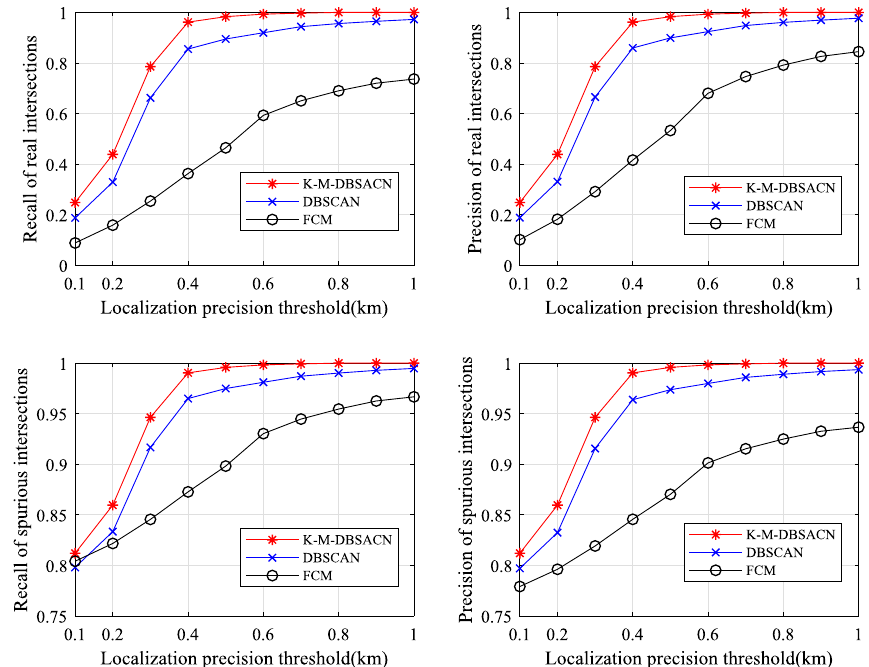
Fig. 9 Comparison of recall and precision versus the localization precision